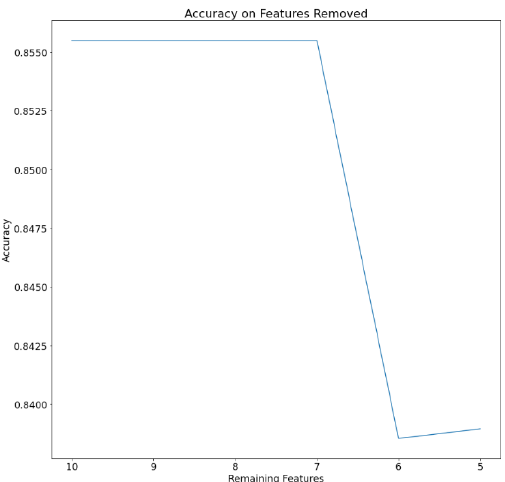
Figure 2. Accuracy of the model by sequentially eliminating 1 feature at each